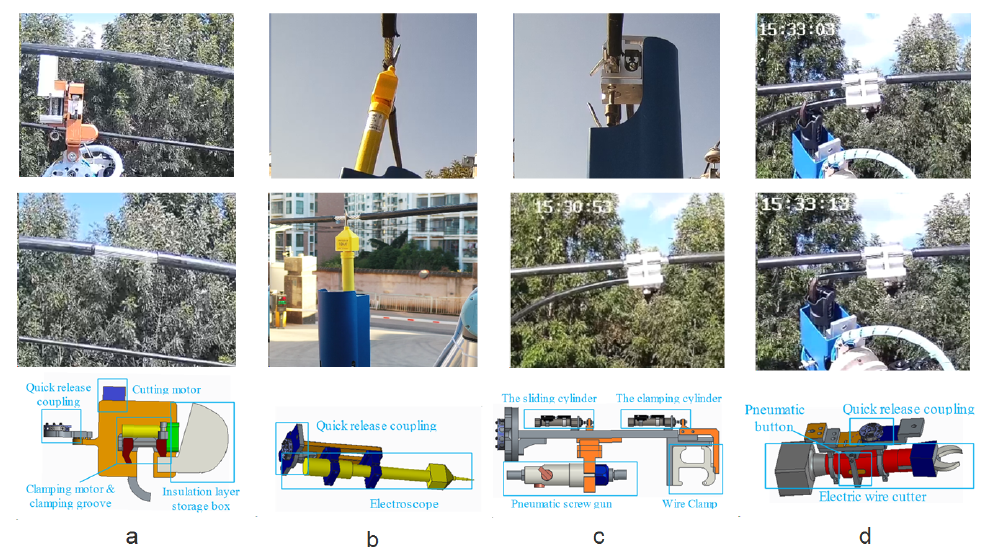
Figure 2. Operations of live-line maintenance [27]. (( a ) Wire stripping, ( b ) voltage detection, ( c ) wire clamp installation, and ( d ) lead-flow wire cut